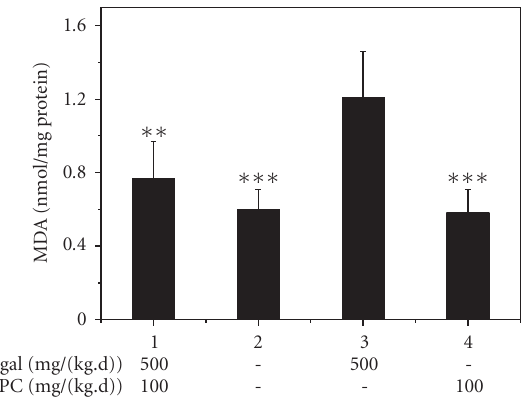
Figure 4: Pharmacological column for e ff ect of PSPC on MDA content. Each value is the means ± SEM ( n = 5). ∗ P < . 05, ∗∗ P < . 01, ∗∗∗ P < . 001 versus D-gal